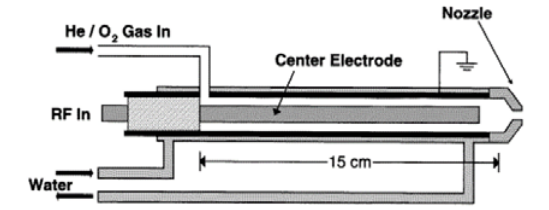
fig 1: Schematic of the dielectric-free electrode atmospheric- pressure plasma jet[11]